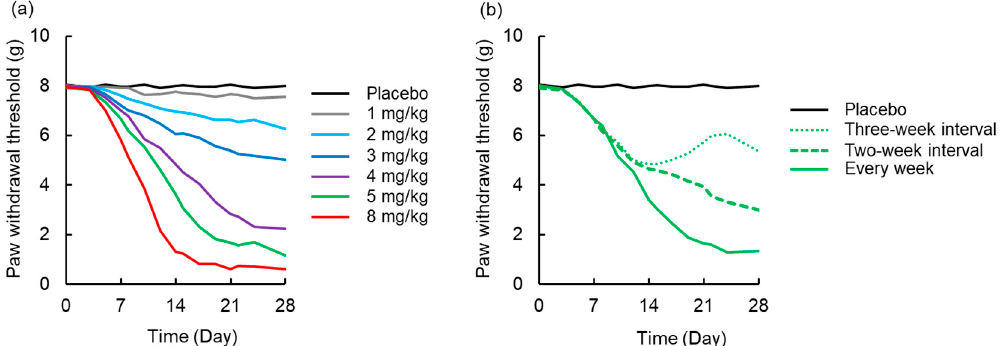
Figure 7. Simulated time-course profile obtained using the pharmacokinetic-toxicodynamic (PK-TD) model for paw withdrawal threshold in the von Frey filament test. ( a ) Simulated data after administration of placebo or L-OHP (1-8 mg/kg) once per week for four weeks, ( b ) L-OHP (5 mg/kg) every week, at two-week interval (Day 0 and 14), and three-week interval (Day 0 and 21). PK-TD parameters: V = 357.8 mL ‧ kg − 1 , k e = 3.4 h − 1 , k 12 = 2.6 h − 1 , k 21 = 1.1 h − 1 , k in,chronic = 2.7 day − 1 , E max,chronic = 168.0, EC 50, chronic = 0.43 μ g ‧ mL − 1 , γ chronic = 4.